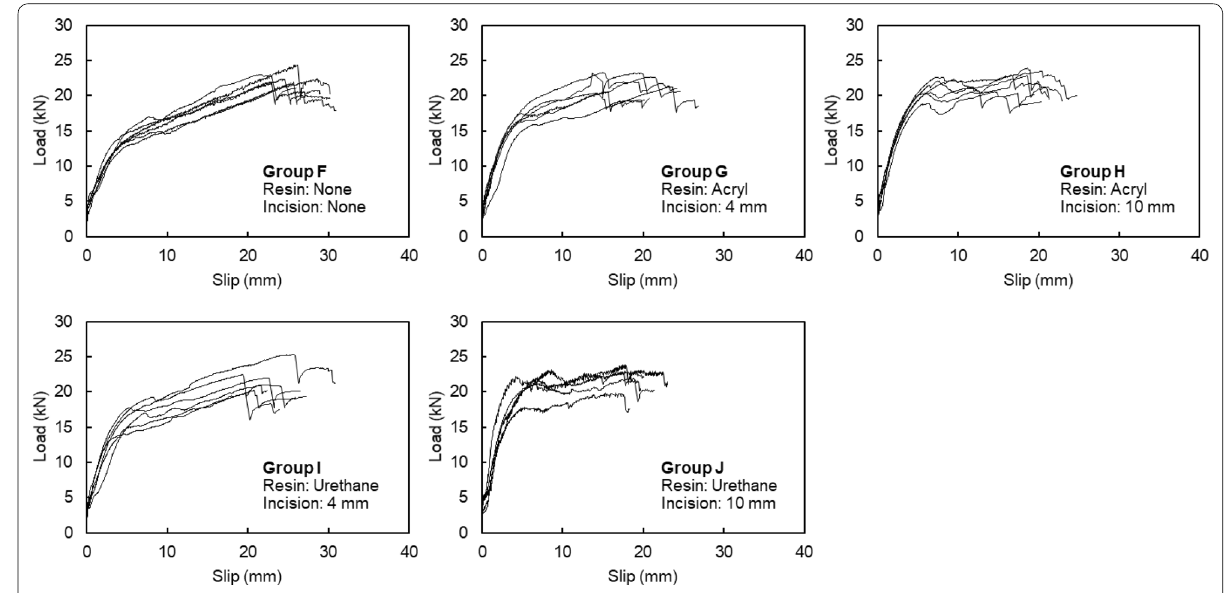
Fig. 8 Load–slip relationships of groups loaded perpendicular to the grain